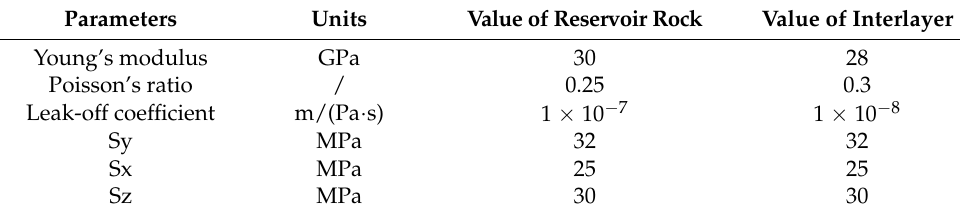
Figure 6. Numerical calculation model ( a ): xoy profile chart, ( b ): yoz profile chart. Table 1. The rock mechanics parameters of the stratum.